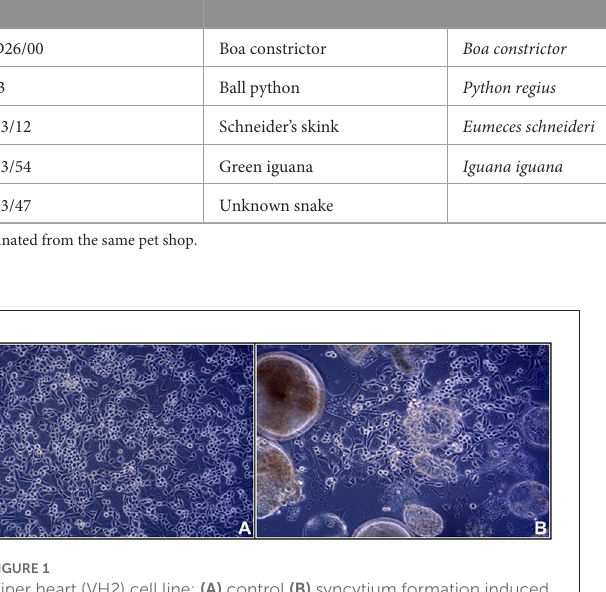
events Recombination Detection Program v4.100 (RDP4) was used applying the default parameters for the embedded methods BootScan, Chimera, GENECONV, MaxChi, RDP, SiScan, and 3Seq